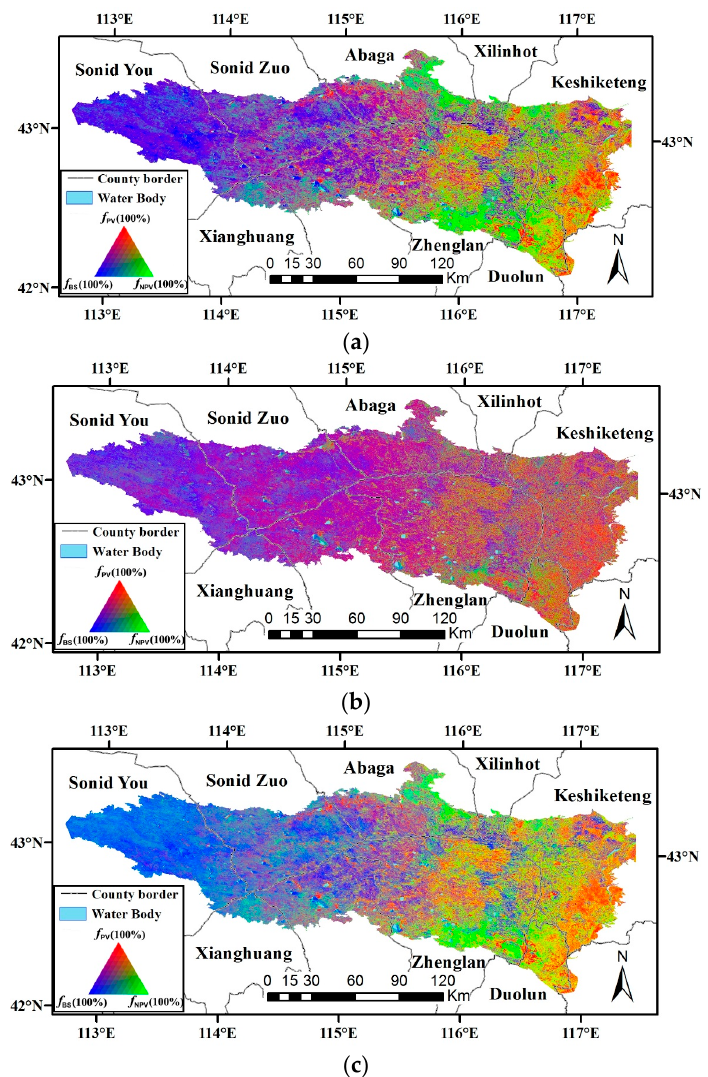
Figure 4. f pv , f npv and f soil estimation based on: ( a ) Spectral Mixture Analysis (SMA); ( b ) Multi-Endmember Spectral Mixture Analysis (MESMA) and ( c ) Automated Monte Carlo Unmixing Analysis (AutoMCU).